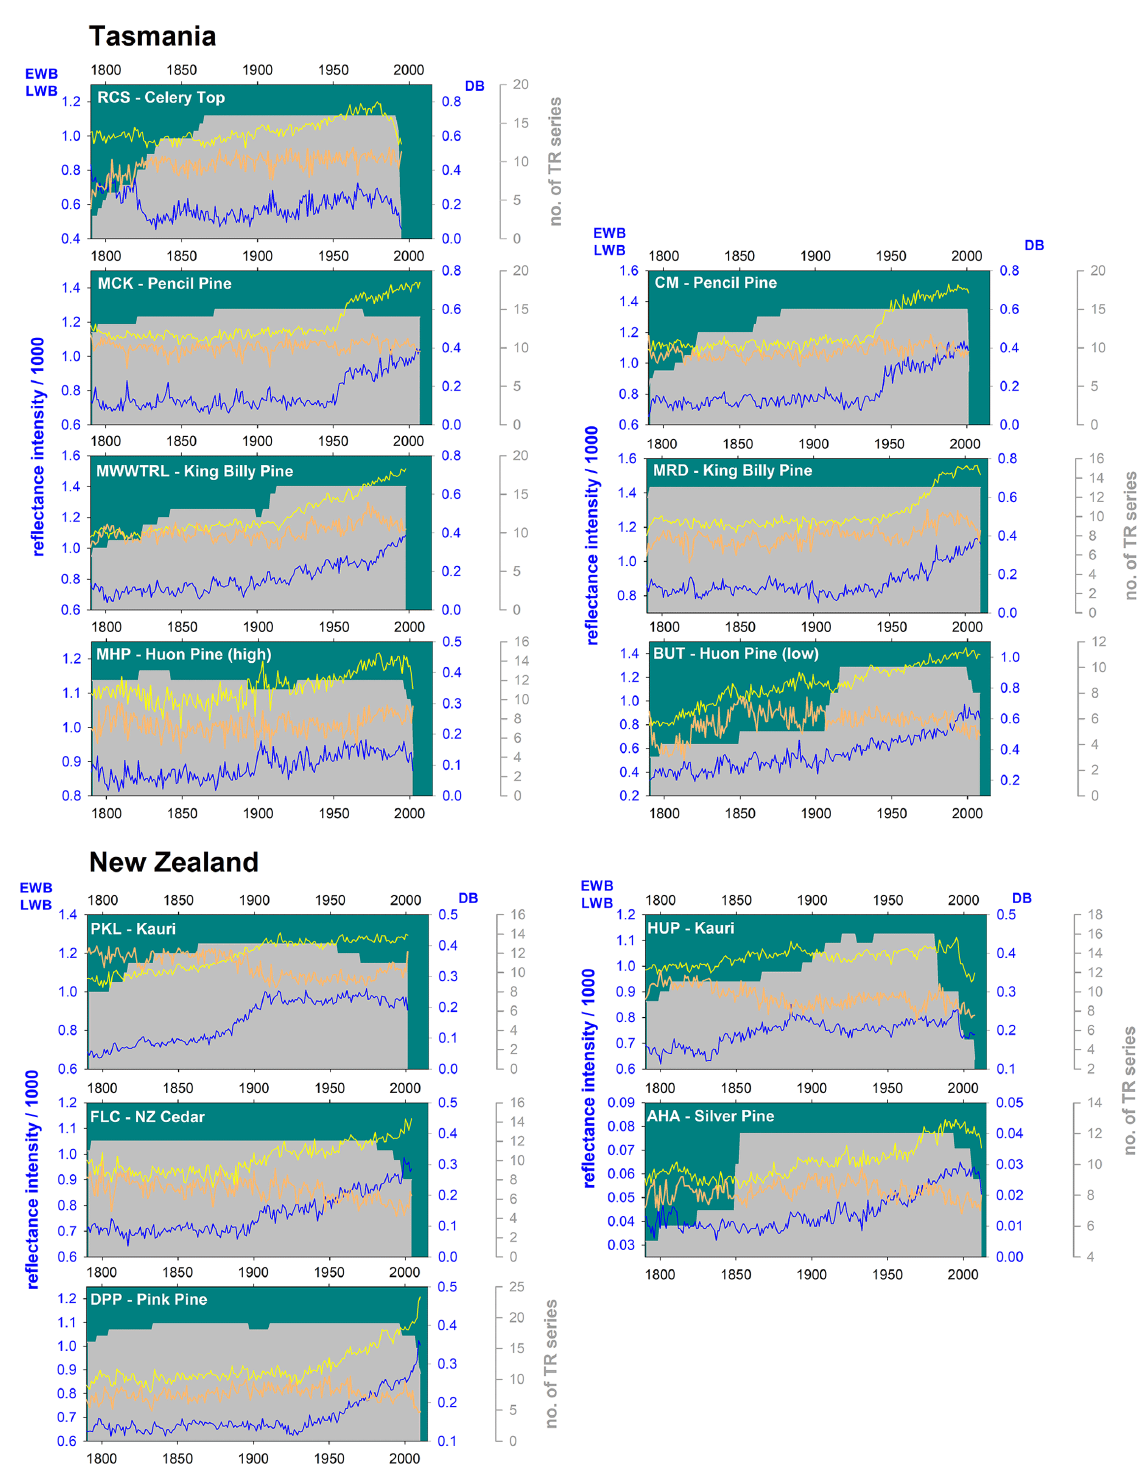
Figure A1. Plots of raw mean chronologies of EWB (yellow), LWB (blue), DB (orange), and TR series replication (grey shading). The left axis is for EWB and LWB, the first right axis is DB, and the second right axis is series replication.